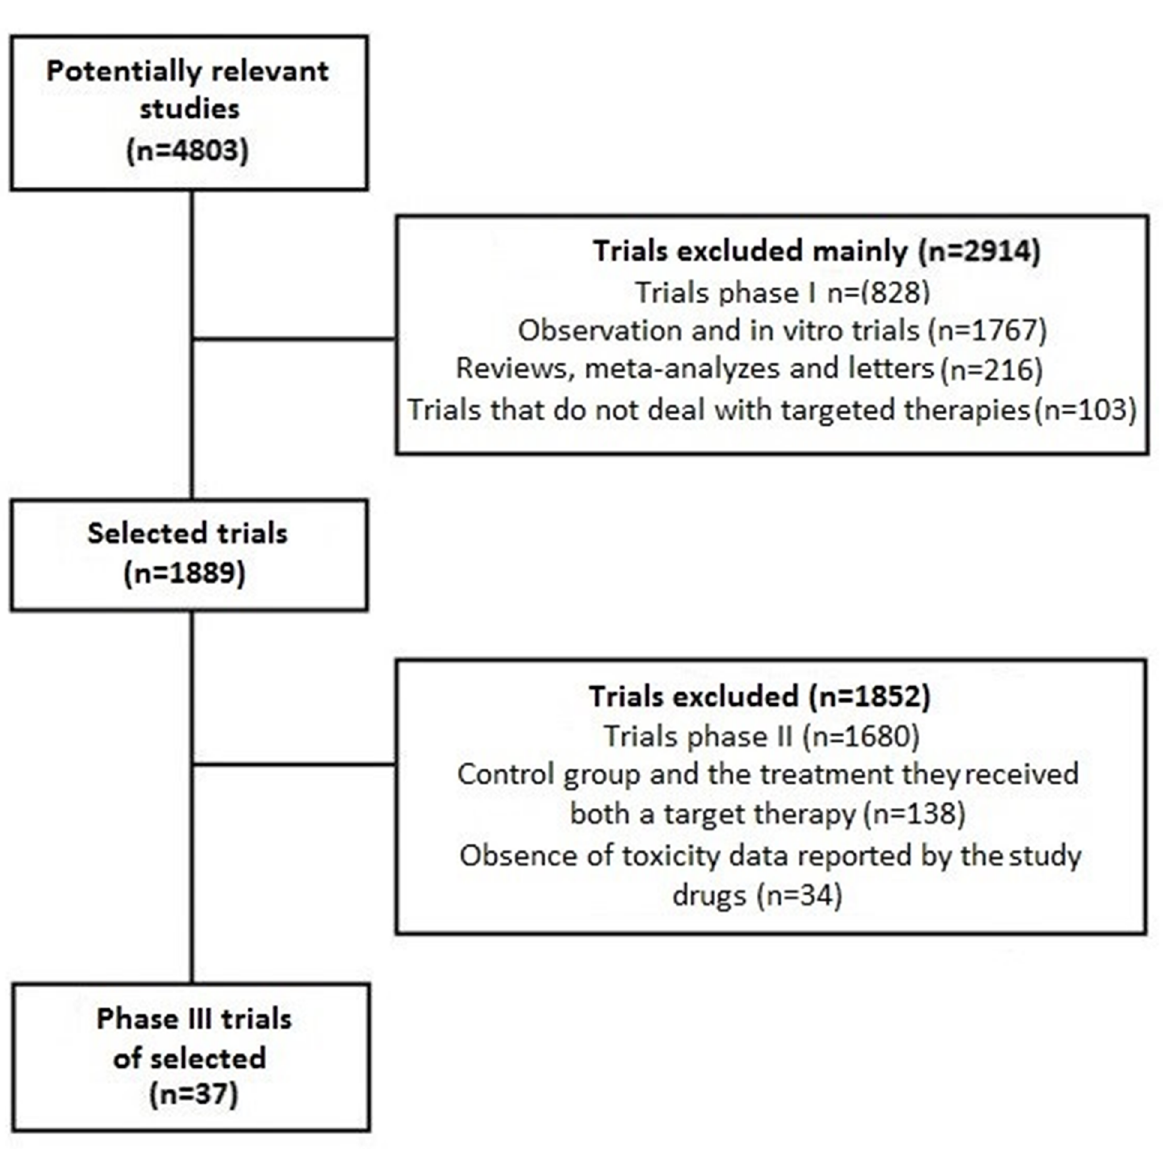
Fig 1. Study selection according to PRISMA